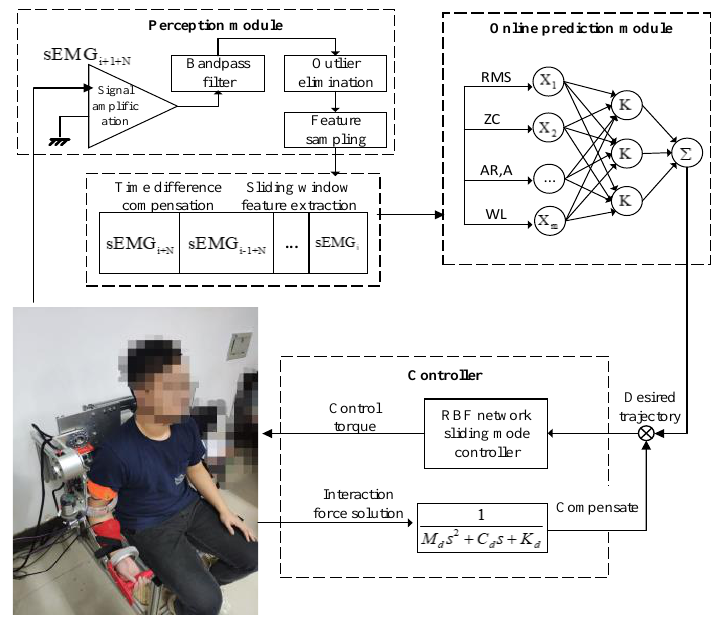
Figure 9. Active rehabilitation training control system. Due to the noise and sudden change in the position, the prediction results of the sEMG could not be applied directly to the actuator. Therefore, a fourth-order Butterworth filter was used to process the prediction results, where the low-pass cut-off frequency was set to f c = 10 Hz, and the stepping position of the actuator was set to be no greater than 0.5R to avoid the generation of human–robot interaction forces due to large prediction values. The processed trajectory curve was relatively smooth, as shown in Figure 10. It can be observed that muscle instability of patients led to changes in the sEMG signals at the highest point, and further led to a decrease in the predicted trajectory within the range of the maximum prediction error e max , which was approximately equal to the mean absolute error (MAE). There was a certain control time delay in the active control process of the predicted expected trajectory points, but the overall tracking performance was good.